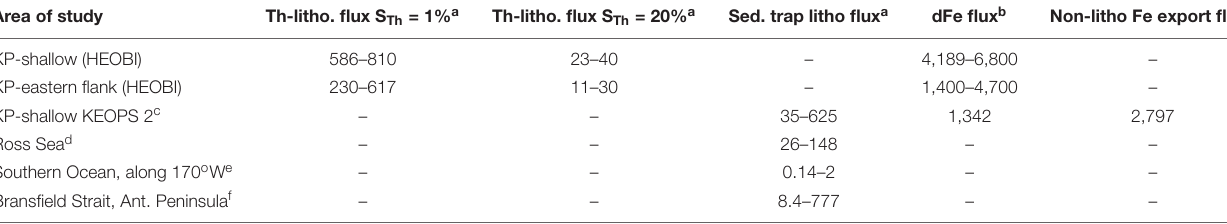
TABLE 4 | Comparison of the Th-derived lithogenic and dissolved Fe fluxes to those reported in the